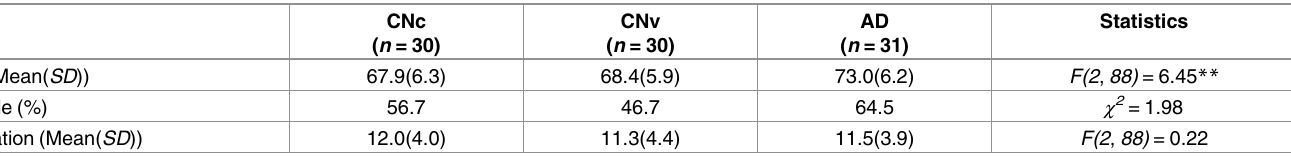
Table 1. Demographic characteristics of the first set.